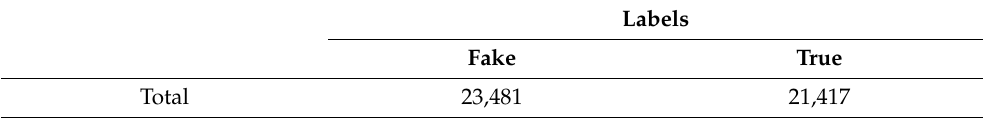
Figure 5. Samples distribution of the ISOT datasets. Table 2. Quantity of Samples in the ISOT Dataset.